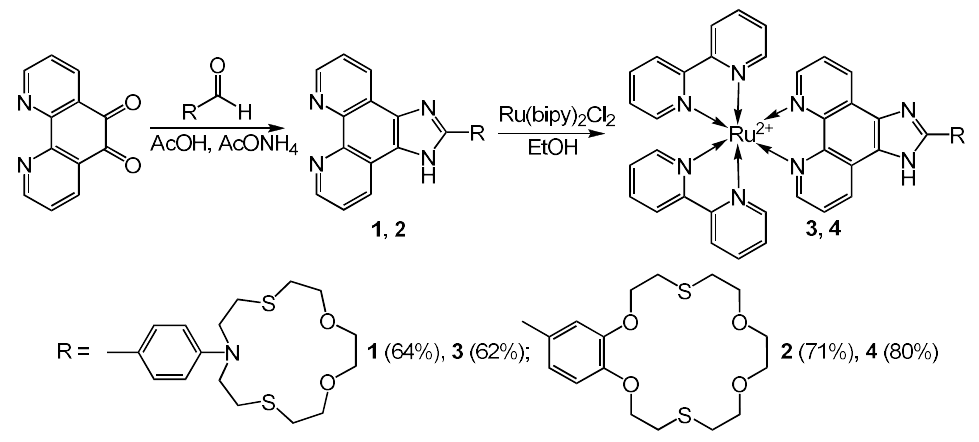
Figure 10. Scheme of the synthesis of ditope ligands.